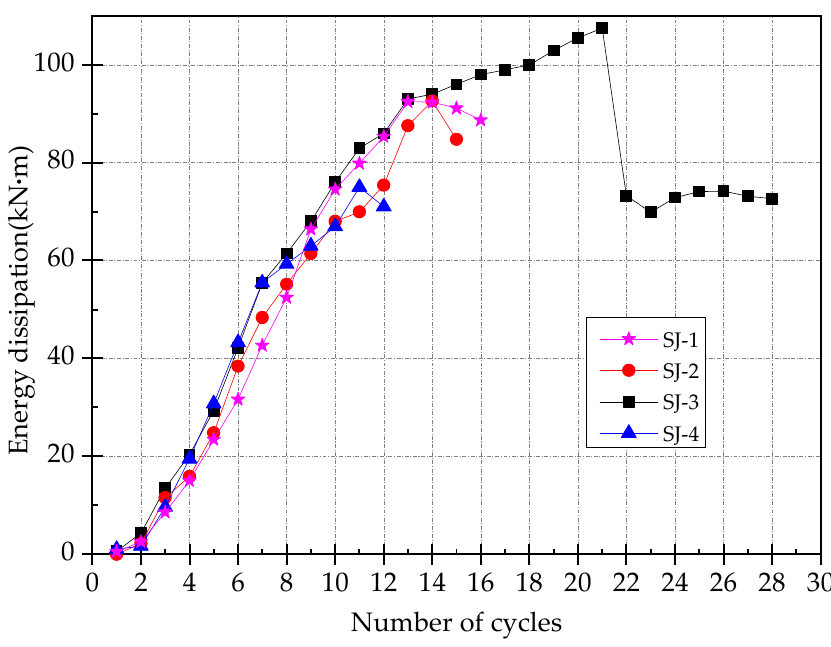
Figure 15. The curves of energy consumption capacity.